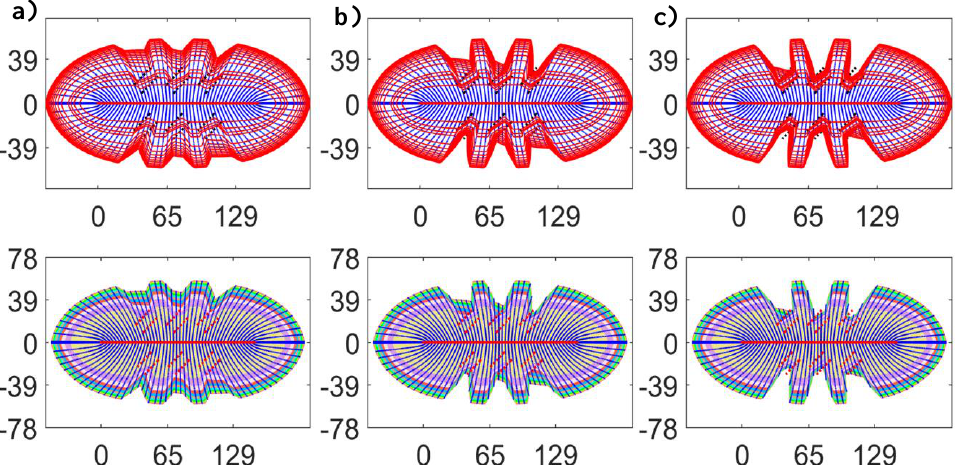
Figure 8. Hydraulic fracture model showing effect of various natural fracture (NF) porosity changes in a reservoir space of 5% porosity with enhanced porosity in the NF of ( a ) 10% ( b ) 15% ( c ) 20%. Streamlines in blue and TOFC in red. Natural fracture zones are shown by dashed lines. The bottom plots use rainbow colors to show drained areas after 3-year time periods.